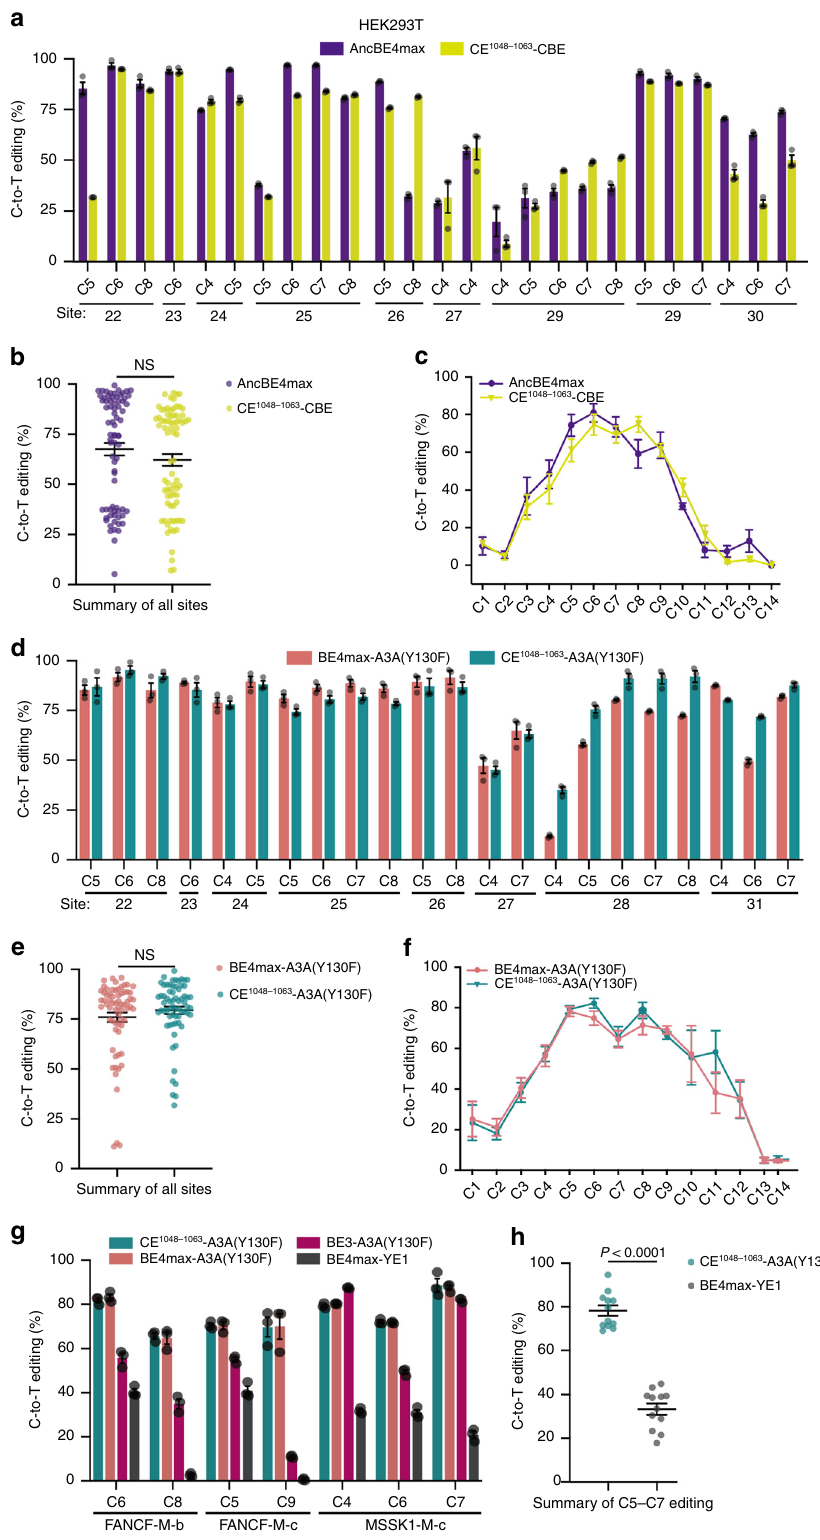
Fig. 3 On-target editing by CE 1048 – 1063 -CBE and CE 1048 – 1063 -A3A(Y130F) in HEK293T cells. a – f CE 1048 – 1063 -CBE was benchmarked against AncBE4max ( a – c ), while CE 1048 – 1063 -A3A(Y130F) against BE4-A3A(Y130F) ( d – f ). The editing rates of the susceptible Cs are shown for individual sites ( a , d ) and as a pool ( b , e ). Also shown are the editing rates of all the Cs along the target region speci fi ed by the gRNA protospacers, as averaged from all the tested sites ( c , f ). The test sites used (#22 – 31) are described in Supplementary Table 1. g , h CE 1048 – 1063 -A3A editing at representative methylated sites 14 . The editing rates at susceptible Cs are displayed for individual sites ( g ) or as a pool ( h ). Values in the a , c , d , f , g are mean ± s.e.m. from three biological replicates. NS not signi fi